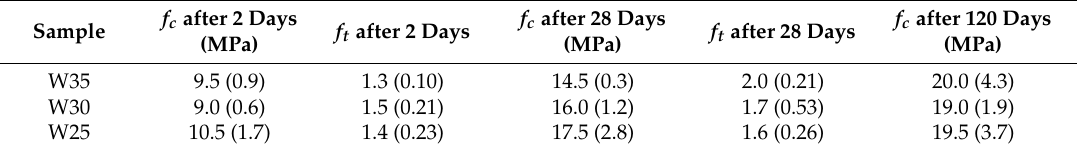
Table 3. Results of compressive ( f c ) and splitting tensile strength ( f t ) including standard deviation.